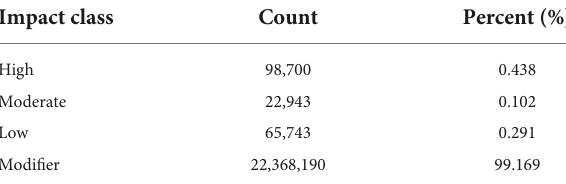
TABLE 2 Effects of the identified INDELs on